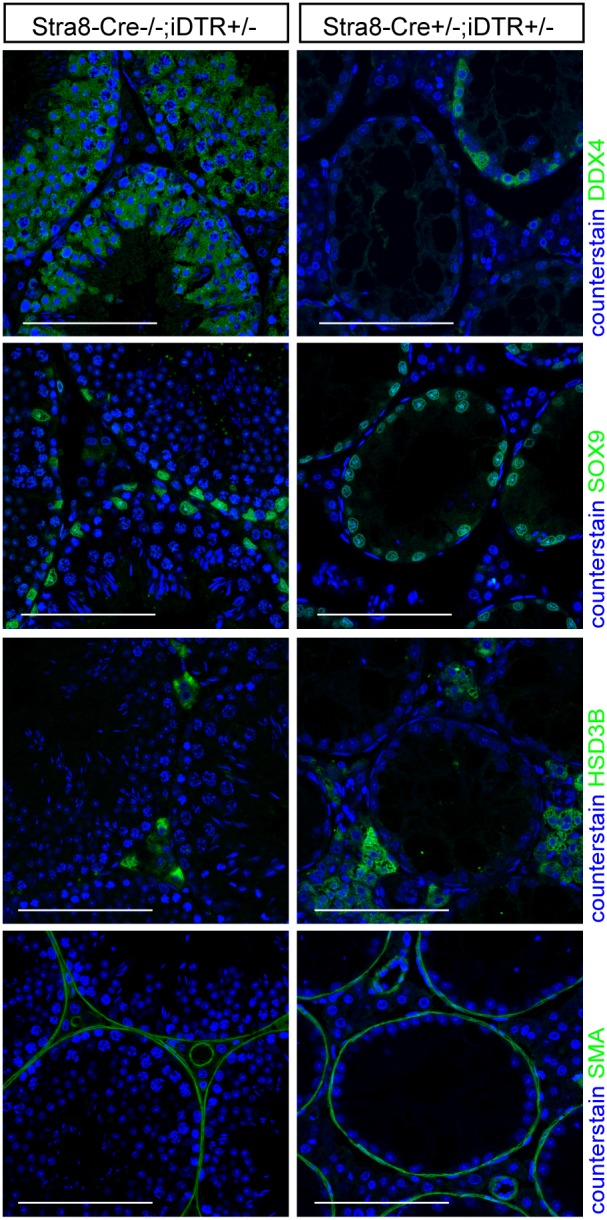
Germ cell-specific cell ablation in adulthood does not impact testicular architecture.Injection of DTX at pnd50 in Stra8-Cre+/−;DTR+/− mice induces specific Germ cell ablation (DDX4 immunolocalization). Testis architecture is unaffected and key testicular somatic cells remain present - Sertoli cell (SOX9), PTMC (SMA), and Leydig cell (HSD3B) (scale bar: 100 µm).